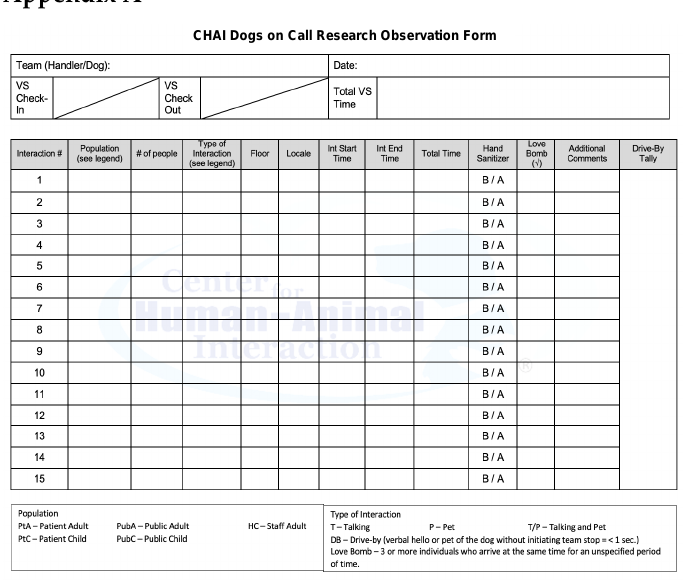
Figure A1. Dogs on Call Visit Observation